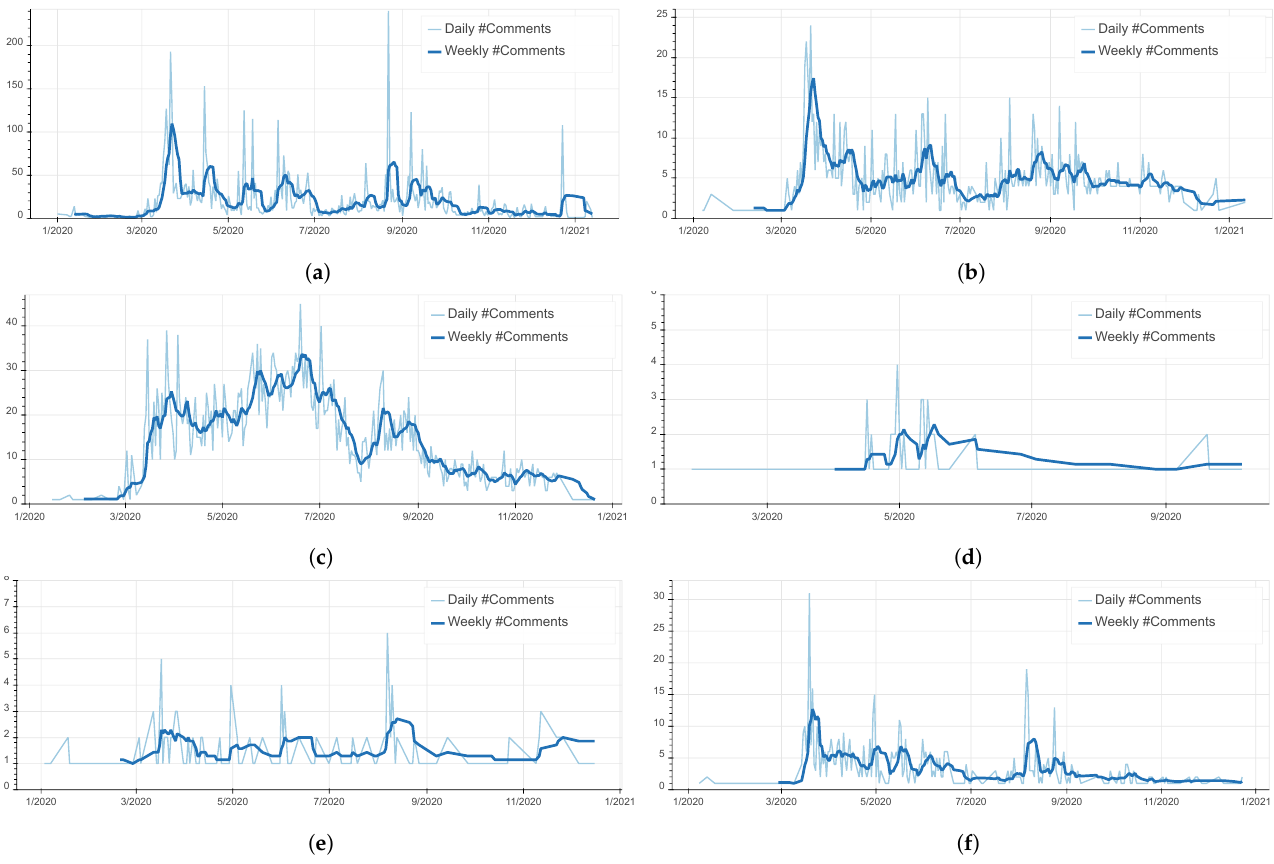
Figure 6. Evolution of emotions in time (Number of comments/Time). ( a ) Evolution of ’Anger’ in time. ( b ) Evolution of ’Fear’ in time. ( c ) Evolution of ’Sadness’ in time. ( d ) Evolution of ’Mistrust’ in time. ( e ) Evolution of ’Optimism’ in time. ( f ) Evolution of ’Approval’ in